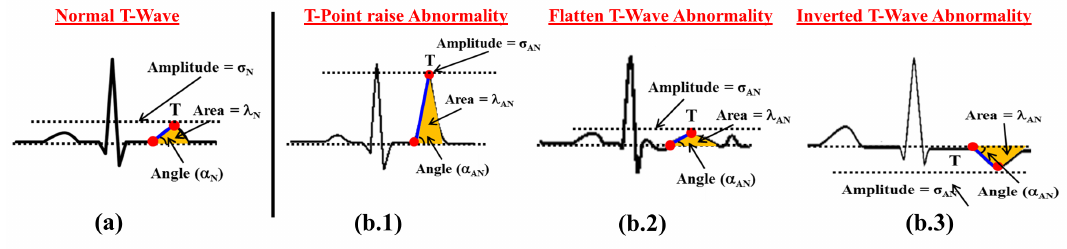
Figure 8. T-Wave abnormality detection method ( a ) Normal T-Wave; ( b.1 – b.3 ) Various T-Wave